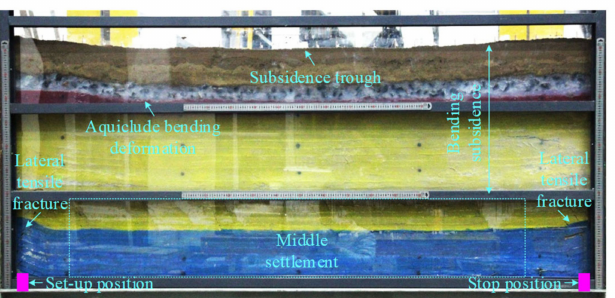
Figure 5. Post-mining overburden movement profile in the weakly cemented rock environment.